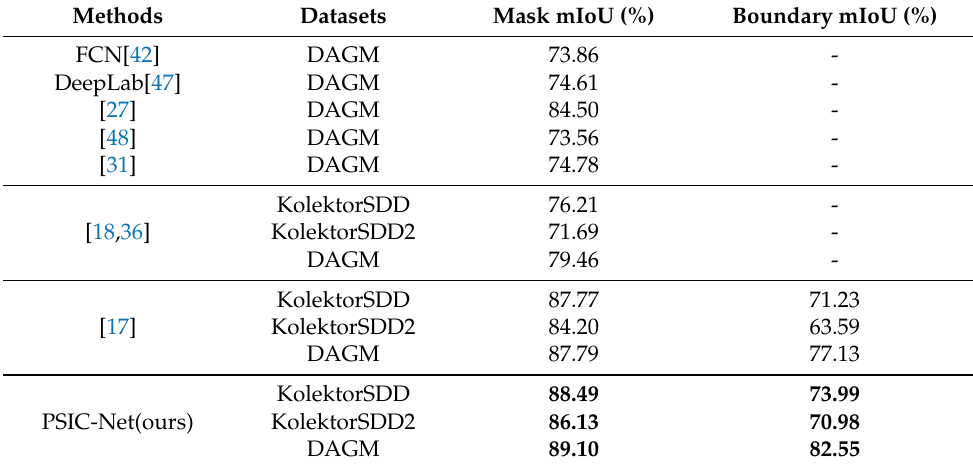
Table 2. Comparison of segmentation effects of various methods and PSIC-Net.